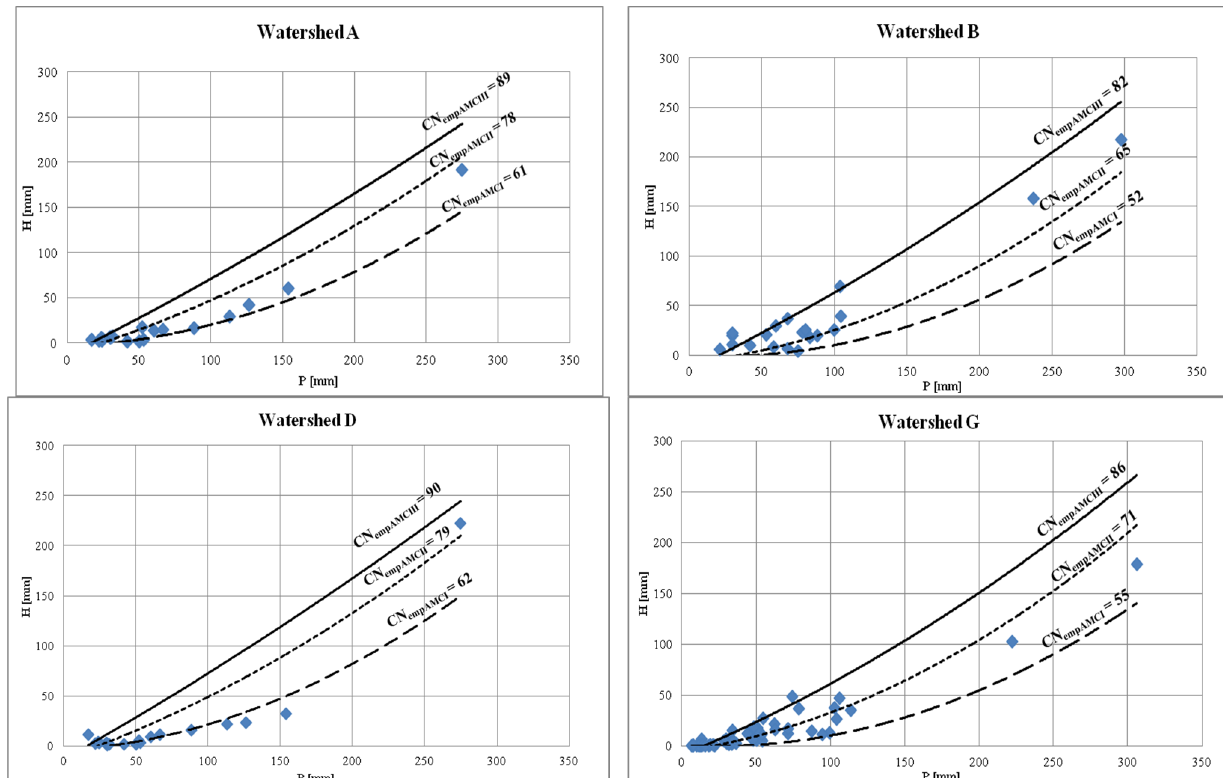
Figure 2. The relationship between runoff Q and rainfall P depth and calculated runoff values for the empirical CN ( CN emp ) for three antecedent moisture conditions in the investigated